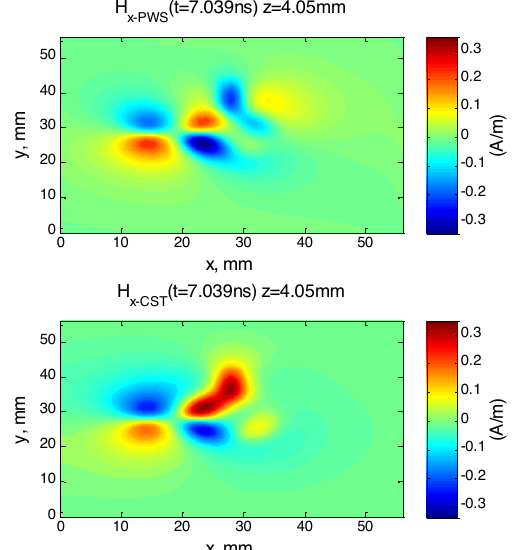
at z = 4.05 mm obtained by z